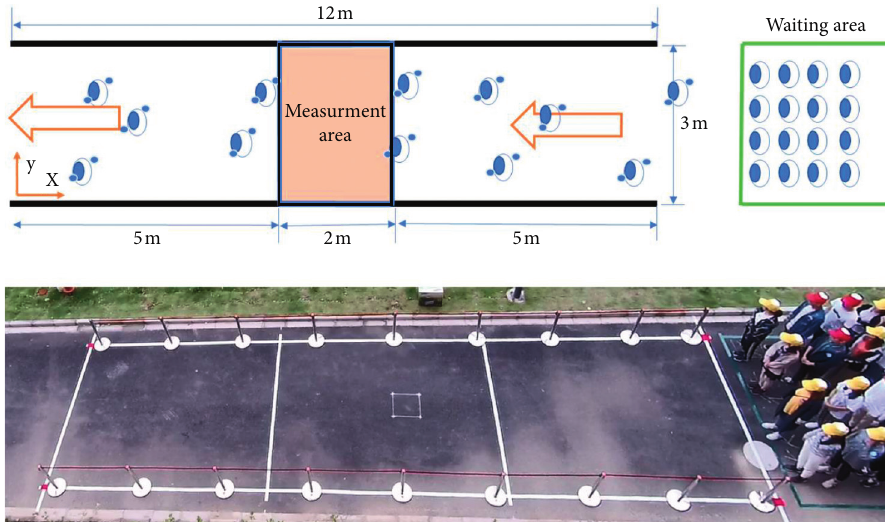
Figure 7: The sketch and screenshot of the experiment setup. It is a long straight corridor with the length of 12m and the width of 3m, and the central area with 2 m × 3m of the corridor is marked as the “measurement area.” The waiting area locates to the west of the corridor, where the participants stood in orderly